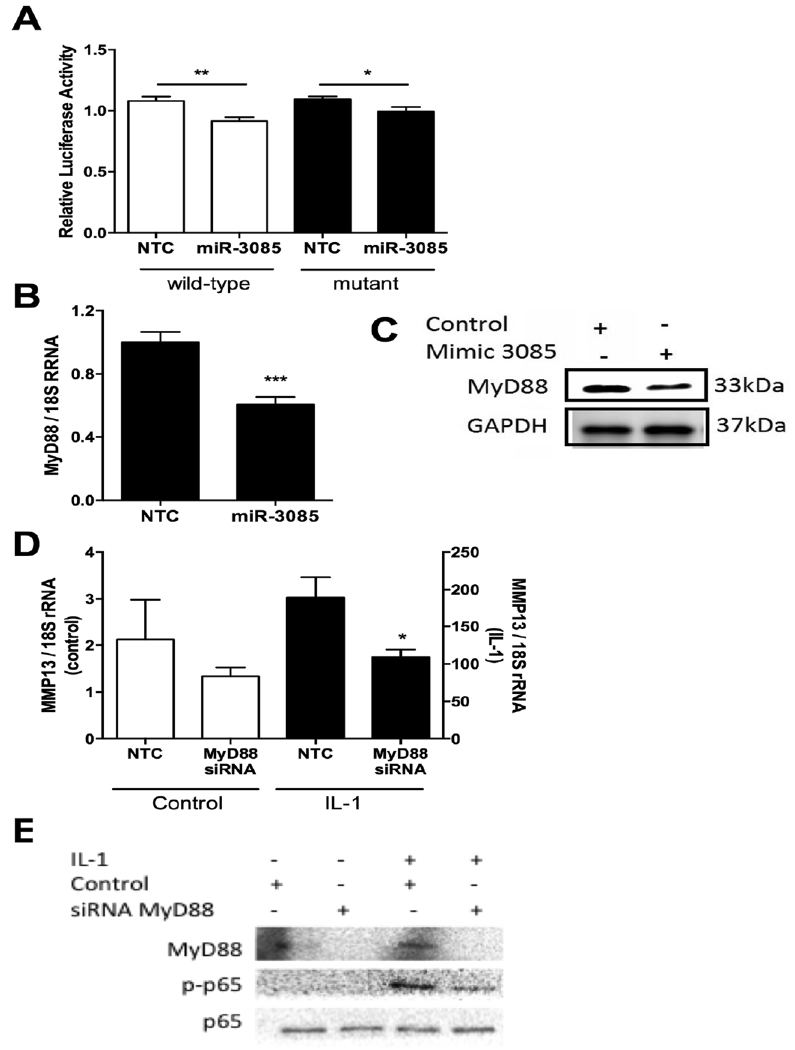
Figure 4. MyD88 is a direct target of miR-3085-3p. ( A ) SW1353 cells were transiently transfected with the MyD88 3 ′ UTR subcloned into the pmirGLO vector (wild-type) or a construct with miR-3085-3p seed sites mutated (mutant) with miR-3085-3p mimic or non-targeting control (NTC) for 24 h. Firefly luciferase relative light units were normalised to Renilla relative light units to give overall relative light units. ( B ) Primary human articular chondrocytes were grown in monolayer culture and transiently transfected with miR-3085-3p or a non-targeting control (NTC) for 48 h; MyD88 was measured by ( B ) qRT-PCR and ( C ) SW1353 cells were transfected with miR-3085-3p or a non-targeting control (NTC) for 48 h, MyD88 protein level were measured by western blot. ( D ) Primary human articular chondrocytes were grown in monolayer culture and transiently transfected with MyD88 siRNA or a non-targeting control (NTC) for 24 h prior to stimulation with IL-1β (5 ng/ ml) or control for 6 h; MMP13 was measured by qRT-PCR. Mean + /- SEM, n = 3. Student’s t-test; * p < 0.05; ** p < 0.01; *** p < 0.001. ( E ) SW1353 cells were grown in monolayer culture and transiently transfected with MyD88 siRNA or a non-targeting control (NTC) for 24 h prior to stimulation with IL-1β (5 ng/ml) or control for 30 min prior to western blot analysis. Full-length blots are presented in Supplementary data; N.B. the full blot for MyD88 in ( C ) is over